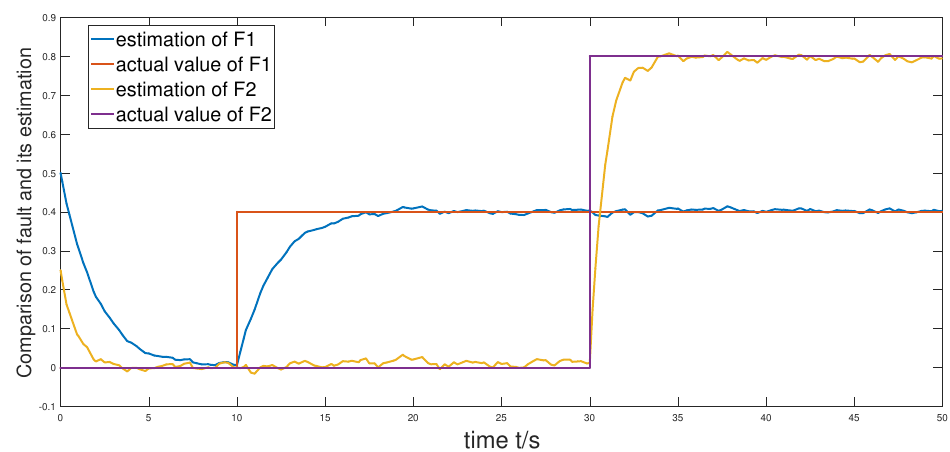
Figure 7. Composite graph of F 1 , F 2 , and their estimations ˆ F 1 , ˆ F 2 .